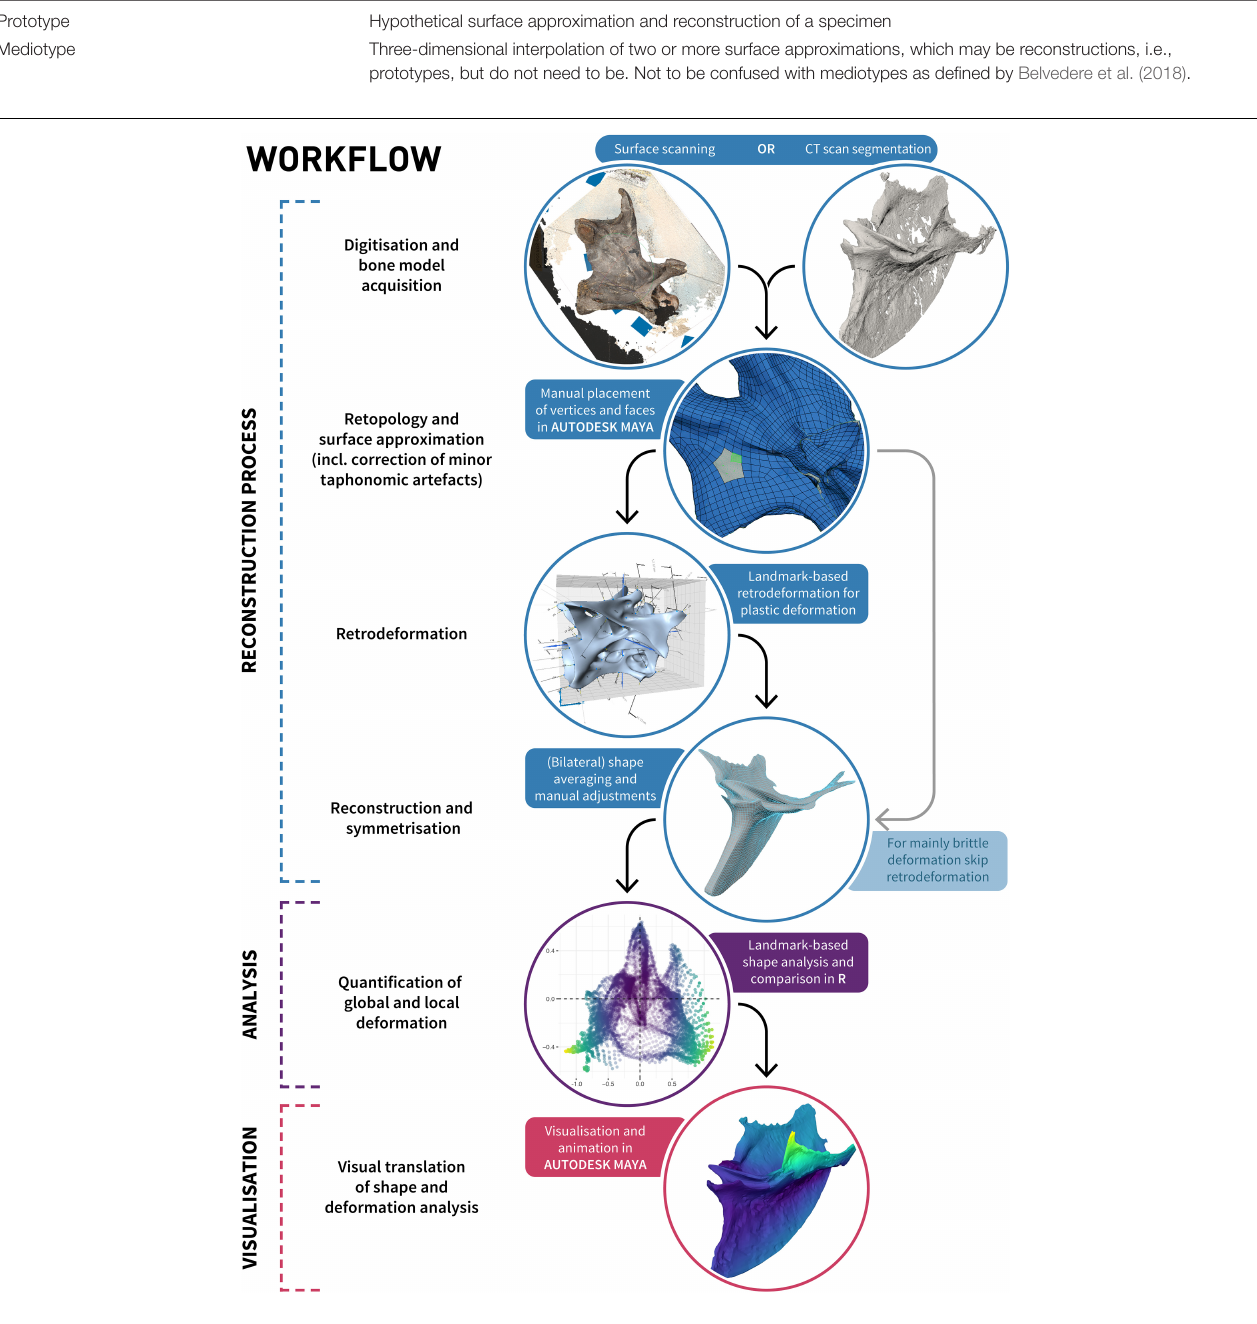
FIGURE 3 | Diagram illustrating the process of retrodeformation, analysis and visualisation of an object using our proposed workflow incorporating